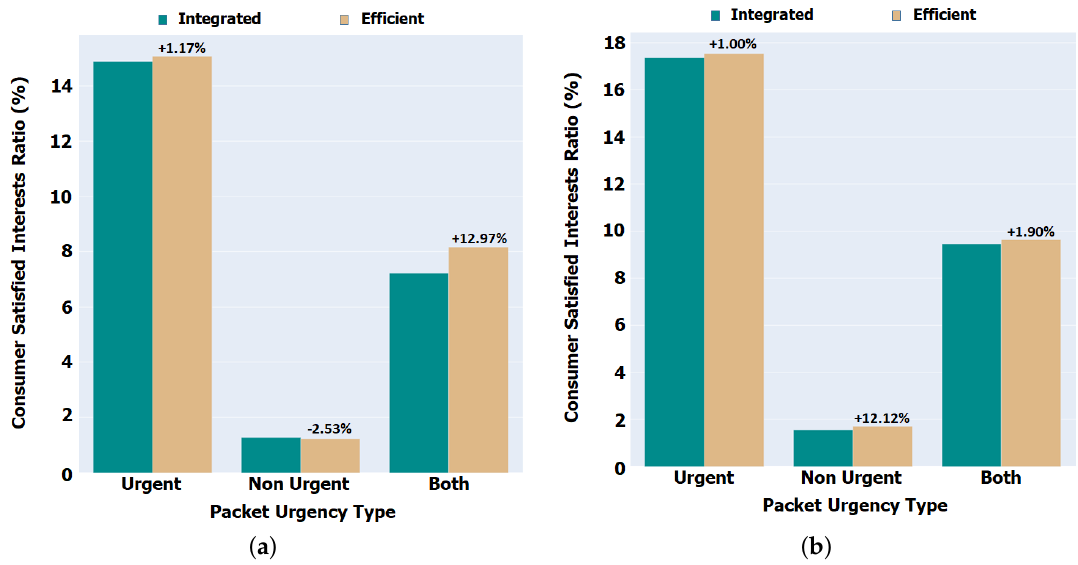
Figure 8. Satisfied Interest Rate (Urgent and Non Urgent). ( a ) Aveiro scenario. ( b ) Porto